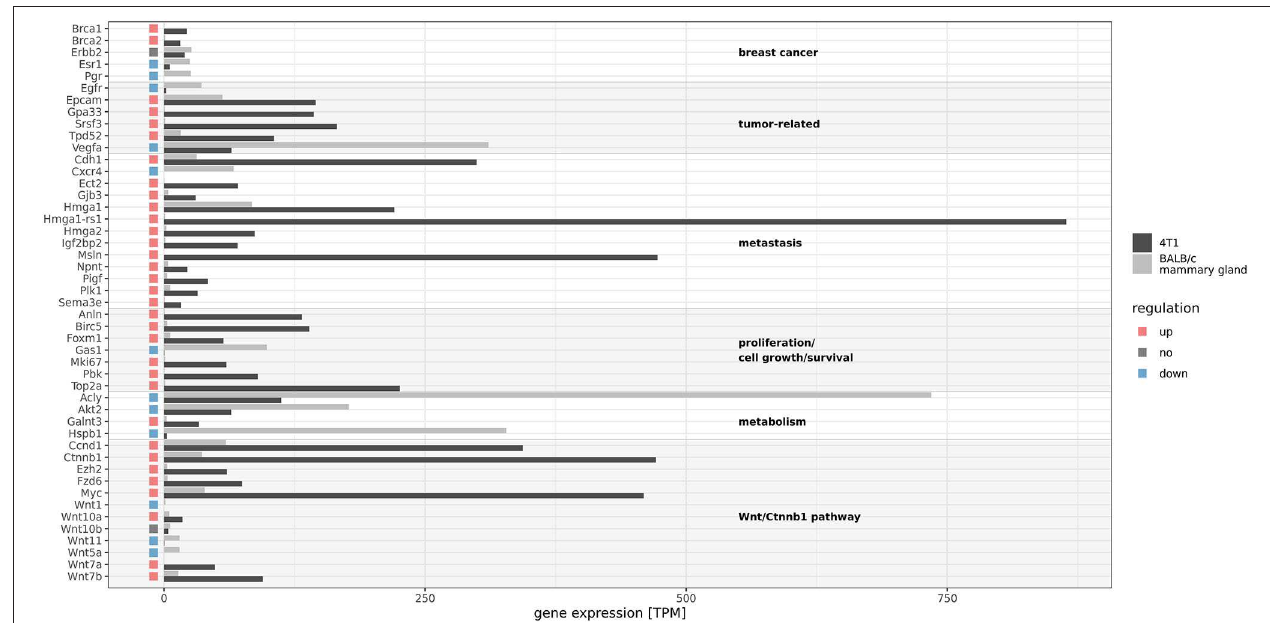
FIGURE 2 | Gene expression of selected genes in 4T1 and BALB/c mammary gland. Gene expression was calculated as the sum of the determined transcript expression values in TPM (transcripts per million) and means of sample duplicates are given in the graph. Red and blue rectangles indicate differential expression (|log2FC| > 1, FDR ≤ 0.05). 4T1 exhibits characteristic gene expression patterns with respect to TNBC genes and other cancer- and metastasis-related